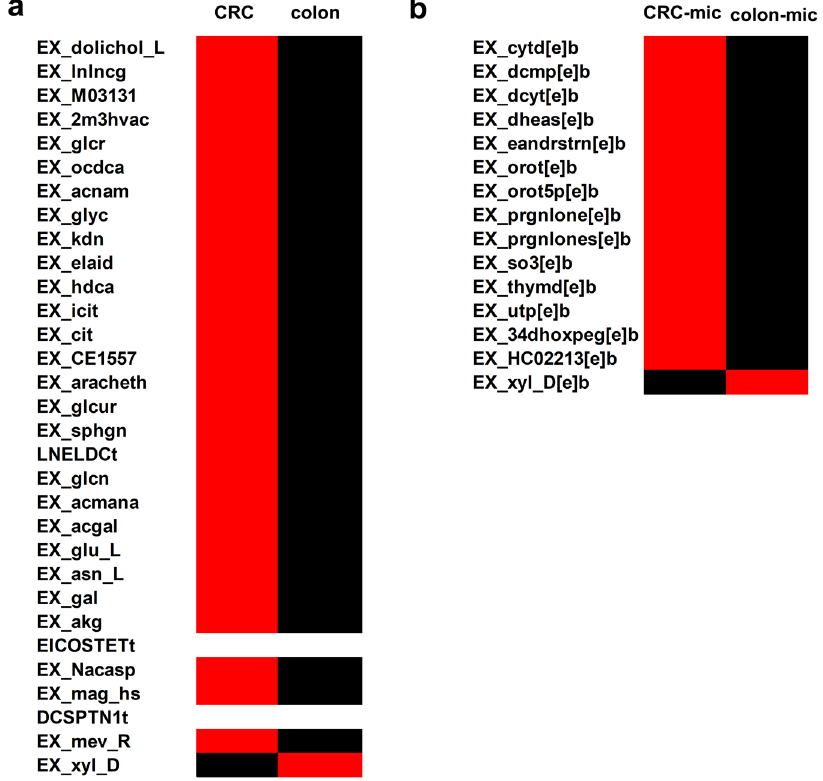
Fig. 7 Metabolite secretion pro fi les of the host and host – microbe models. a Colon vs. CRC and b colon – microbe vs. CRC – microbe. Exchange reactions with increased fl uxes are depicted in red, with the same fl uxes in white and reduced fl uxes in